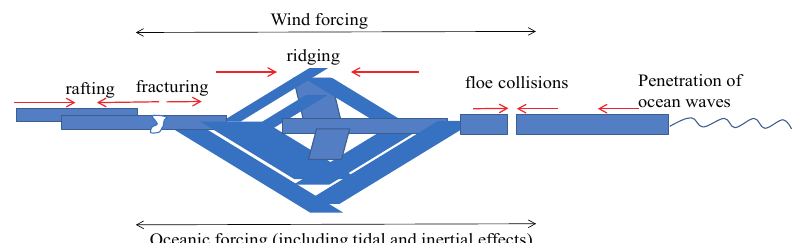
Figure 8. Processes generating mechanical waves travelling within sea